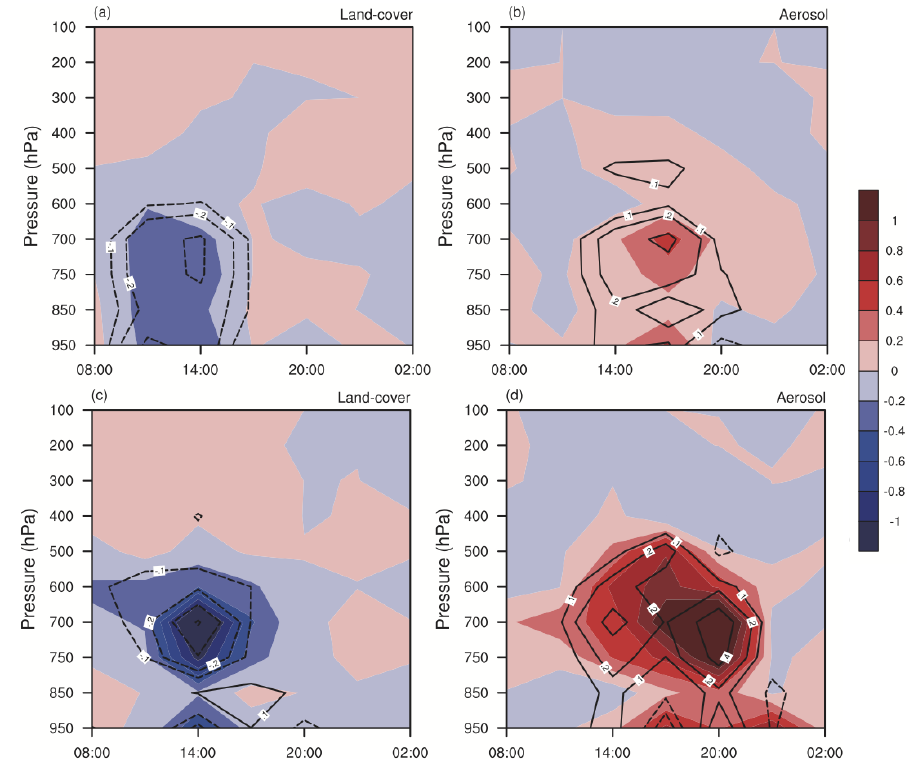
Figure 16. Same as Fig. 15 but for differences in the first term ( − V ctrl · (cid:49)( ∇ q) ) (shaded; units: 10 − 4 g − 1 kg − 1 s − 1 ) and the second term ( − ( ∇ q) ctrl · (cid:49)V ) (black lines; units: 10 − 4 g − 1 kg − 1 s − 1 ) in Eq.